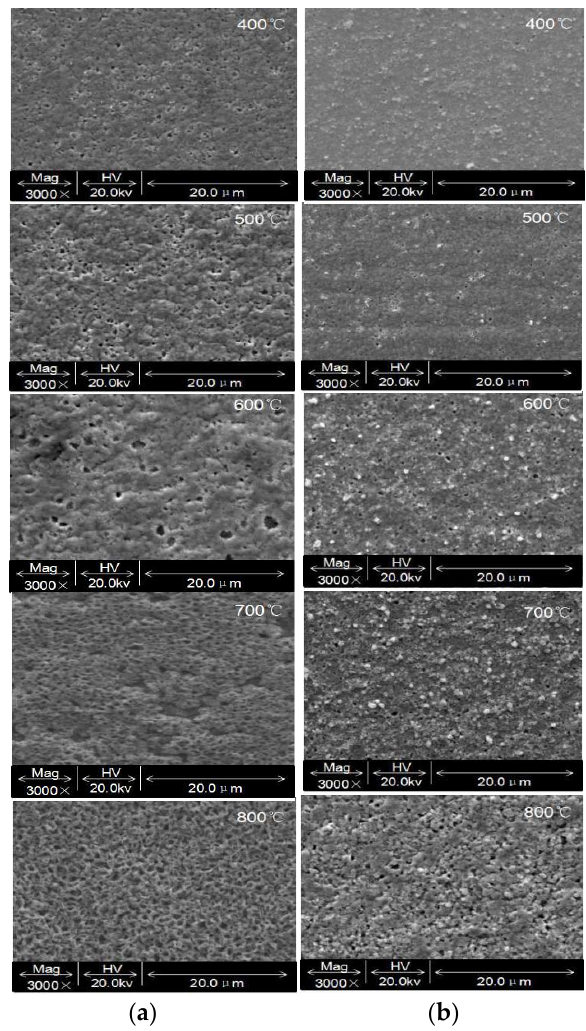
Figure 7. SEM image of Ni coating and Ni/ZrO 2 gradient coating after 12 h high temperature treatment: ( a ) Ni coating, ( b ) Ni/ZrO 2 gradient coating.